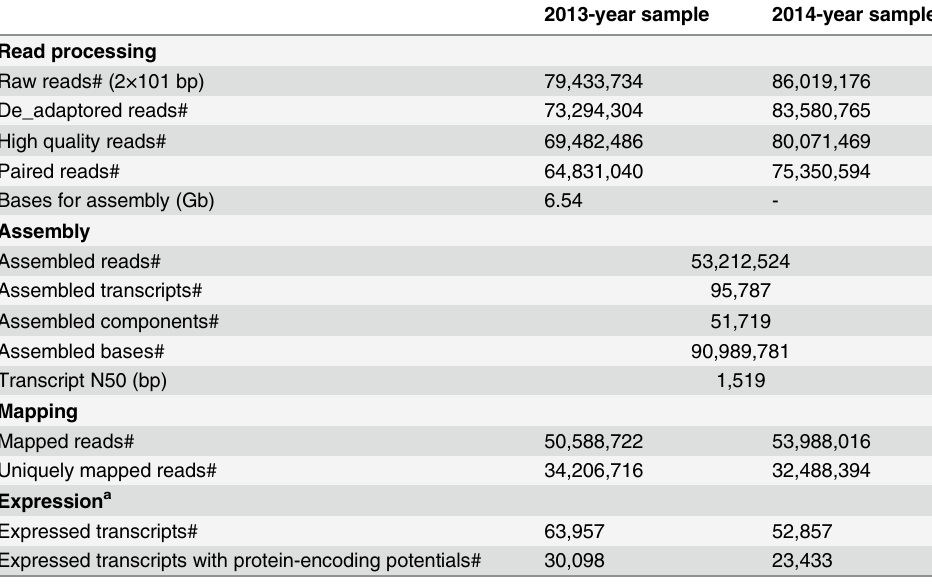
Table 1. Description of sequencing data and de novo